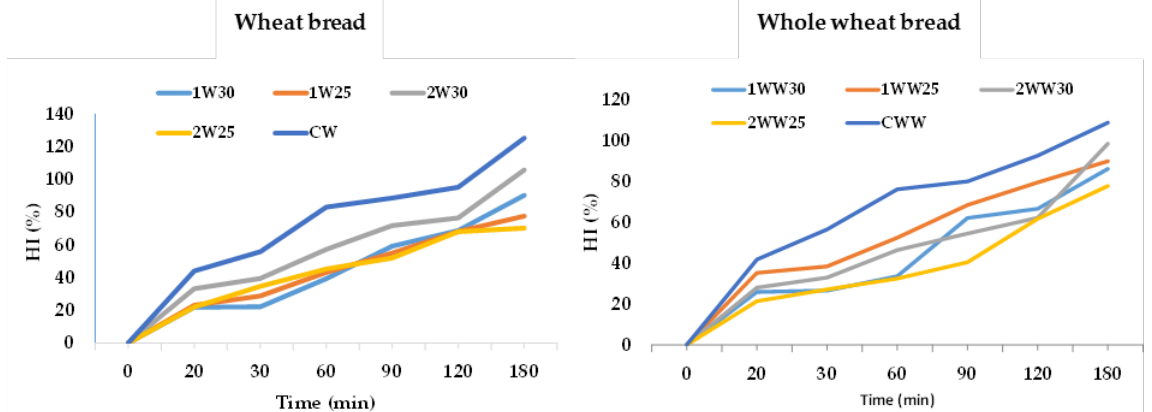
Figure 2. The hydrolysis curves for the sourdough and control bread samples.